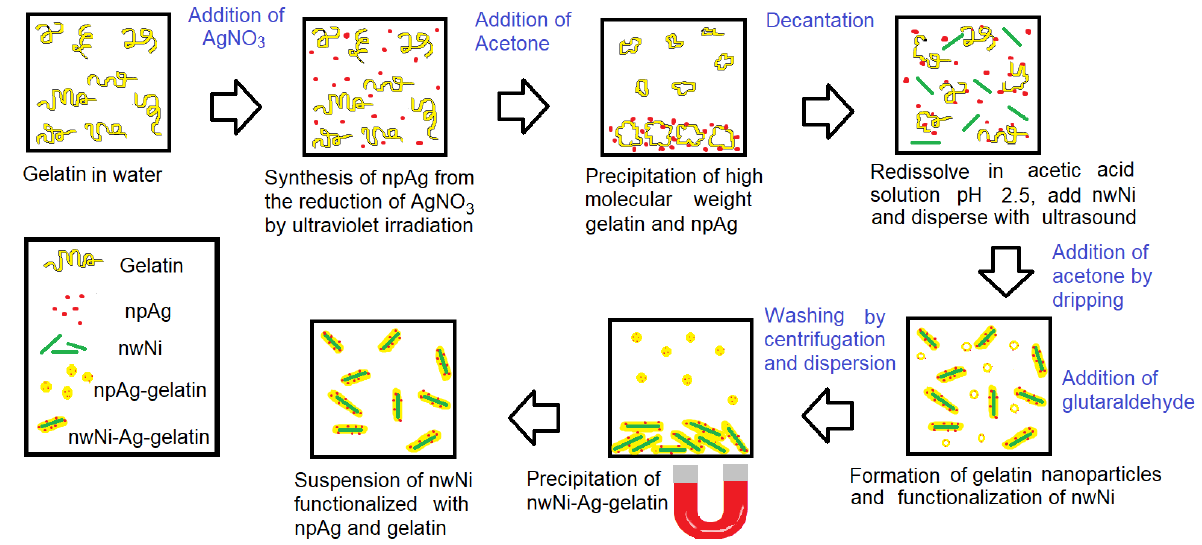
Figure 1. Schematic of the coating of NiNWs with AgNPs/gelatin.